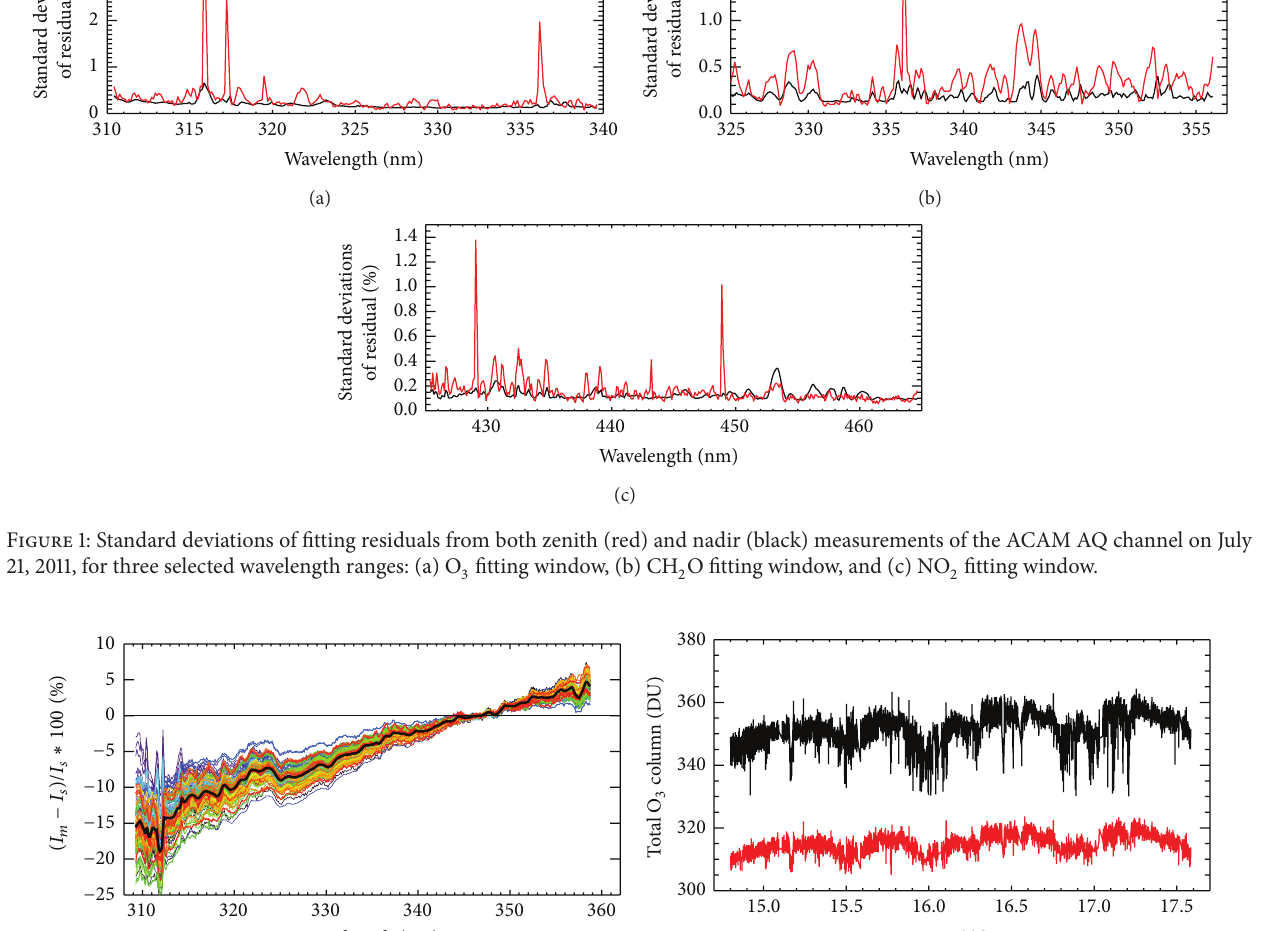
we use ozonesonde profiles measured at Beltsville (39.1 ∘